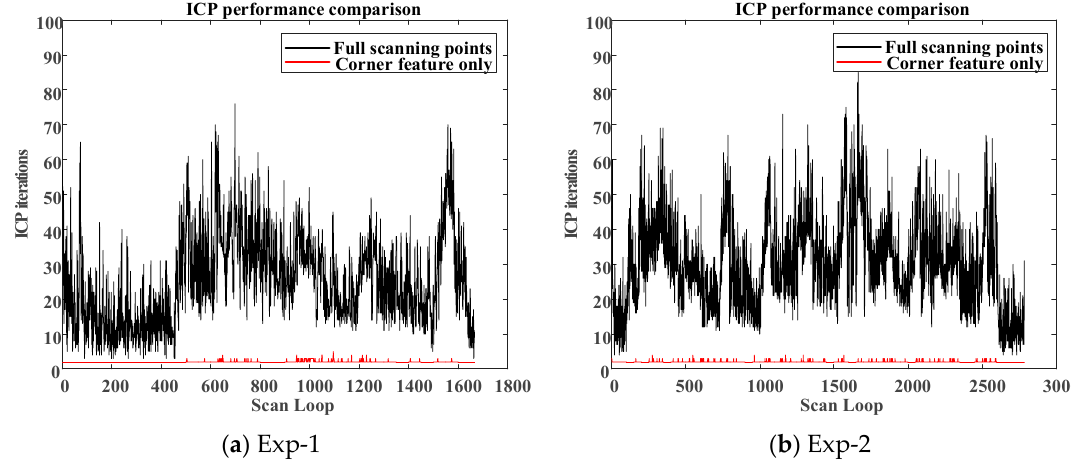
Figure 12. ICP performances of the first/second experiments.